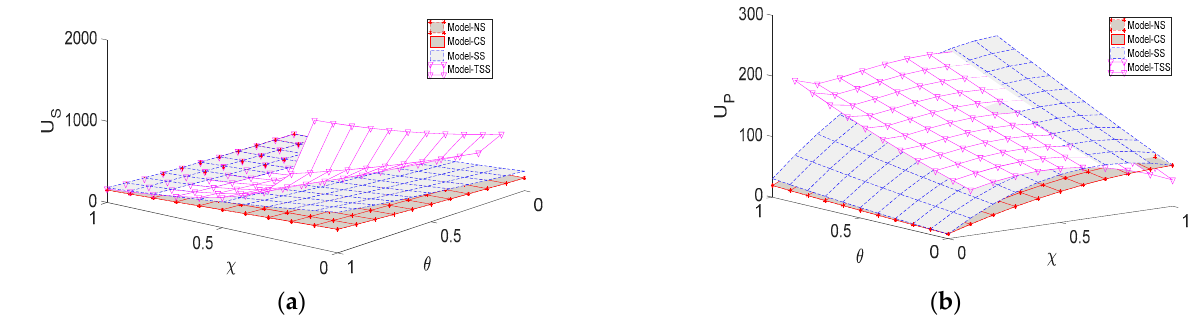
Figure 7. Impacts of the influence coefficient of the greenness level θ and the platform’s environmental concern coefficient χ on the utilities of supply chain members. ( a ) Supplier utility. ( b ) Platform utility.